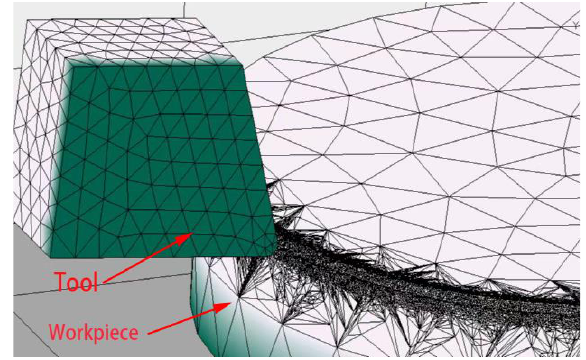
Figure 7. Finite element simulation model.